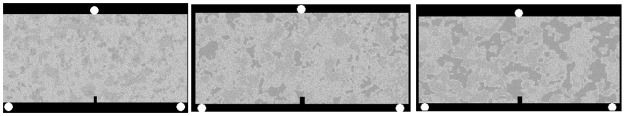
The 3-p-b numerical model of three kinds of granite with notched length.